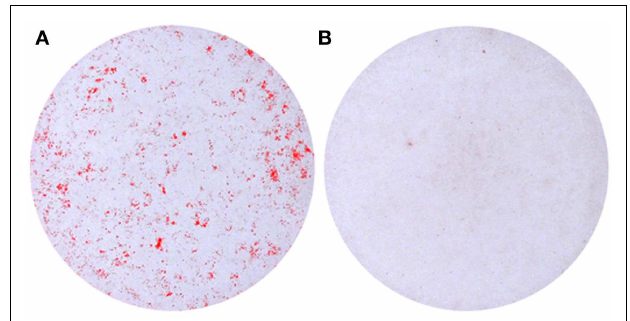
FIGURE 2 | Calcification of murine vascular smooth muscle cells cultured in vitro in the presence of (A) high phosphate (2.5mM) compared to (B) control